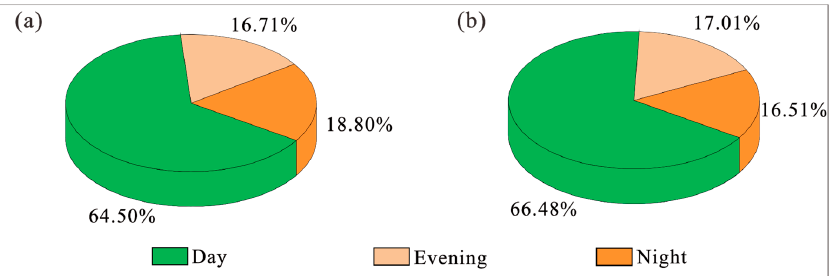
5 of 19 Figure 4. Noise reduction effects before and after using the low-noise aircraft type during summer: ( a ) area; ( b ) population. 2.2. Regulation of Night Flight Numbers The other practical scheme to alleviate the harmful effects of airport noise on nearby residents is to regulate the number of night flights [14,15]. In the present study, the influ- ence of night flights on the overall L WECPN of BIA was investigated. The assessment of L WECPN was according to the national standard GB9661-88 [31], and the equation to cal- culate L WECPN is shown in the equation below. L WECPN = L ¯ EPN (cid:3397) 10lg (cid:4666) N 1 + 3 N 2 + 10 N 3 (cid:4667) (cid:3398) 39.4 (1) where L EPN is the energy average of effective perceived noise level, N 1 , N 2 and N 3 are the number of aircraft during the day (7:00 ∼ 19:00), evening (19:00 ∼ 22:00) and night (22:00 ∼ 7:00), respectively. To conduct the analysis, the daily average number of flights at BIA was collected from the airport control center. The percentages of the number of flights in the day, even- ing and night are summarized in Figure 5. It is noted that, similar to the aircraft types in summer and winter, the percentages of the flight numbers in different time periods are